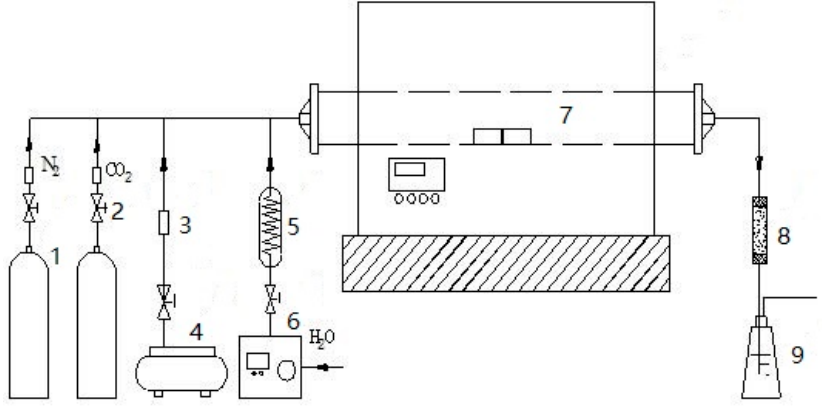
Figure 3. High-temperature tube furnace. 1, Cylinders; 2, needle valve; 3, pressure gauge; 4, air compressor; 5, water steam generator; 6, plunger pump; 7, high temperature tube furnace; 8, tar absorber; 9, gas